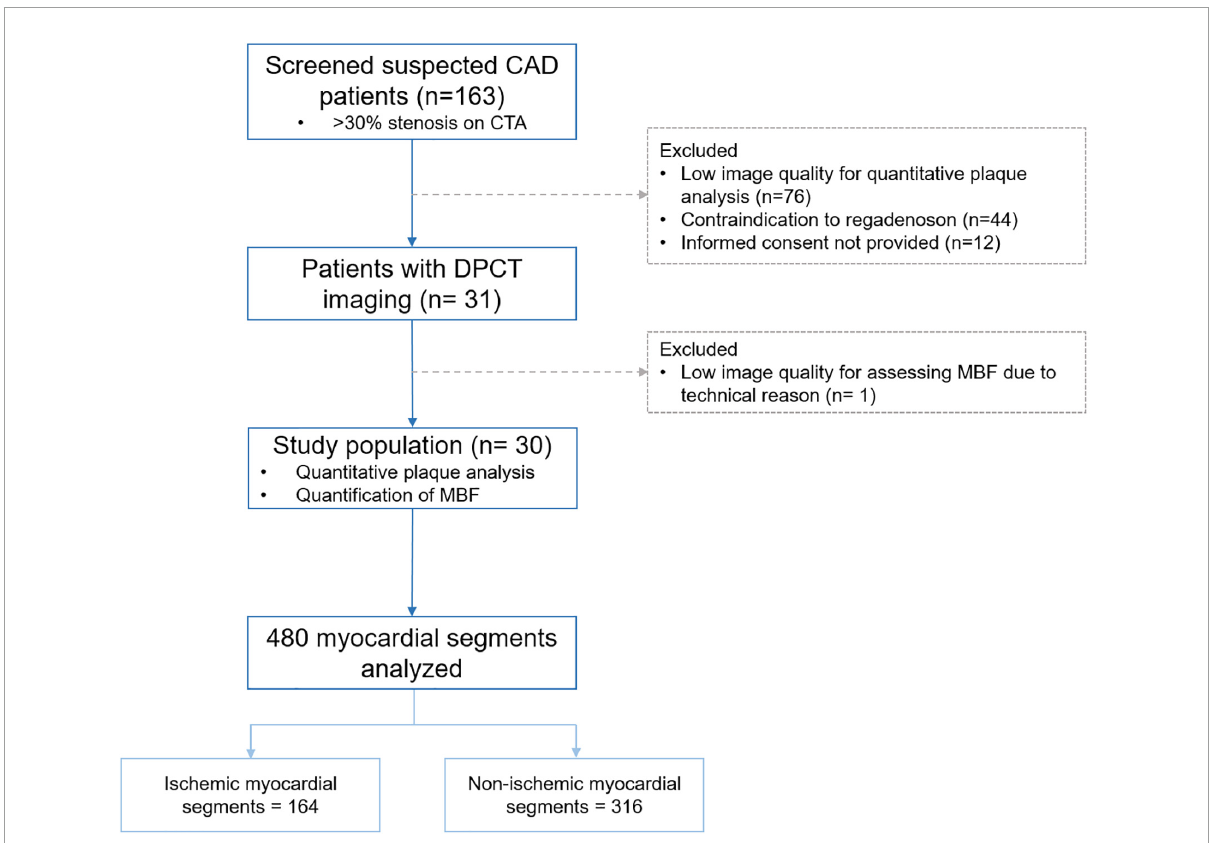
FIGURE1 Flow-chart of the study. CAD, Coronary artery disease; CTA, CT angiography; DPCT, Dynamic perfusion CT; MBF, Myocardial blood